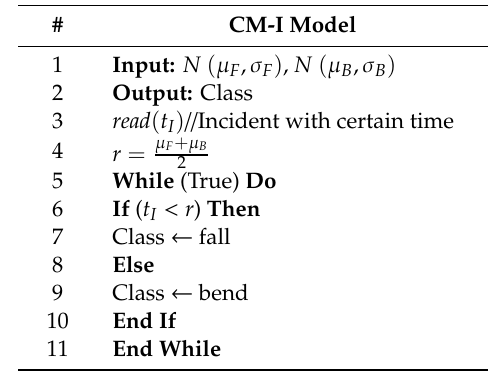
Table 1. Classification Model